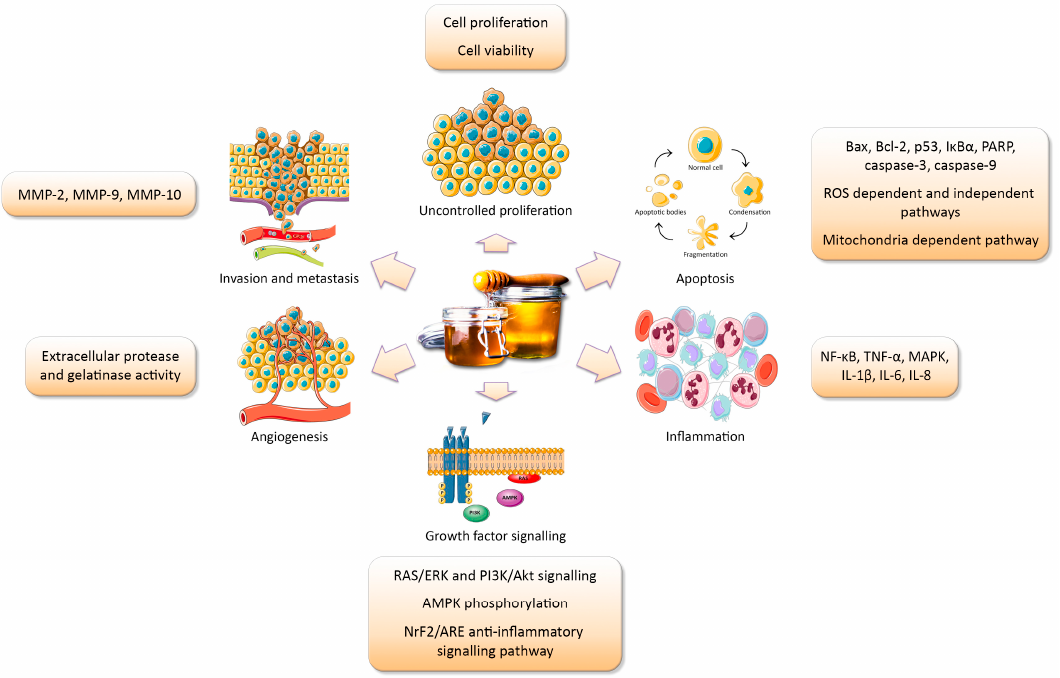
Figure 1. The carcinogenic processes likely to be targeted by honey.